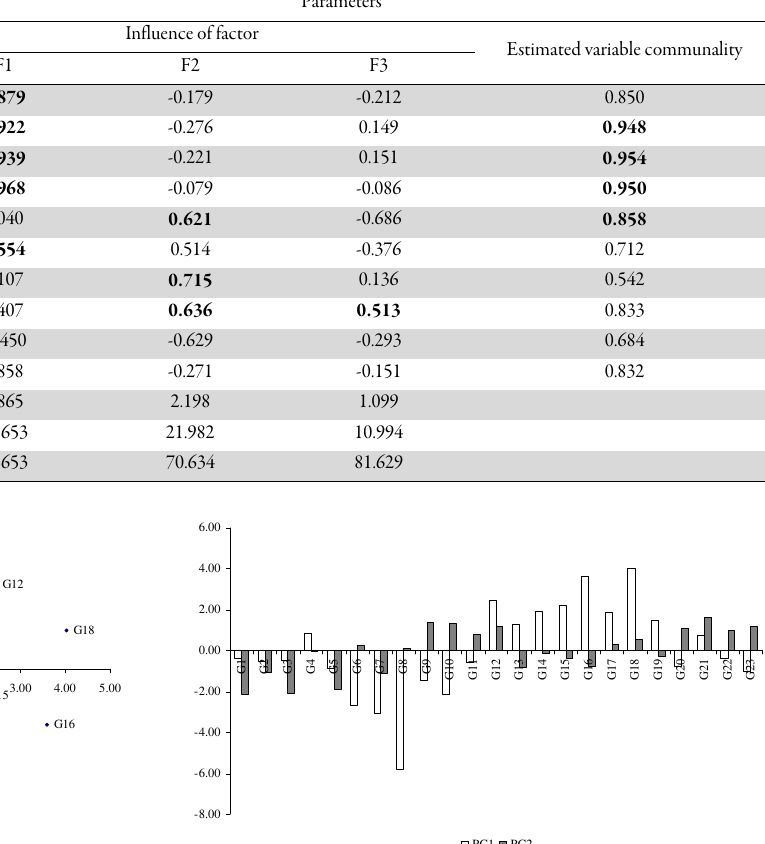
Table 2. The Eigen values for main traits in white lupine cultivars Trait